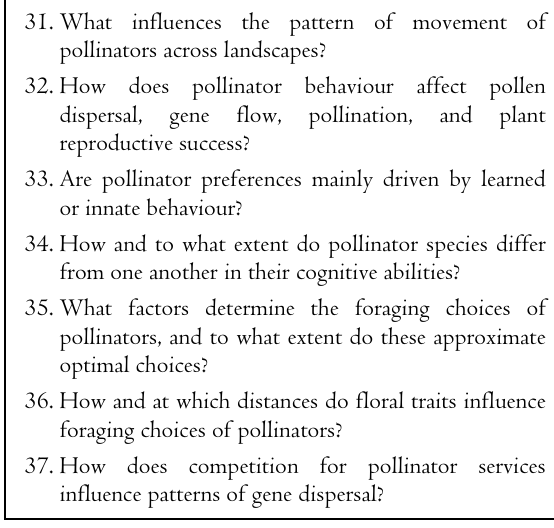
Box 6: Questions on pollinator